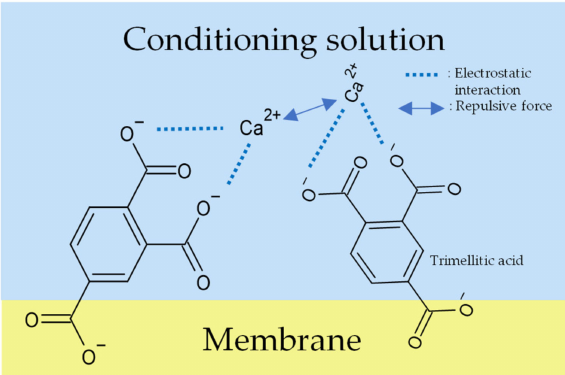
Figure 11. Models of response mechanism of the sweetness sensor with lipid/polymer membranes: membrane in conditioning solution including Ca 2+ .